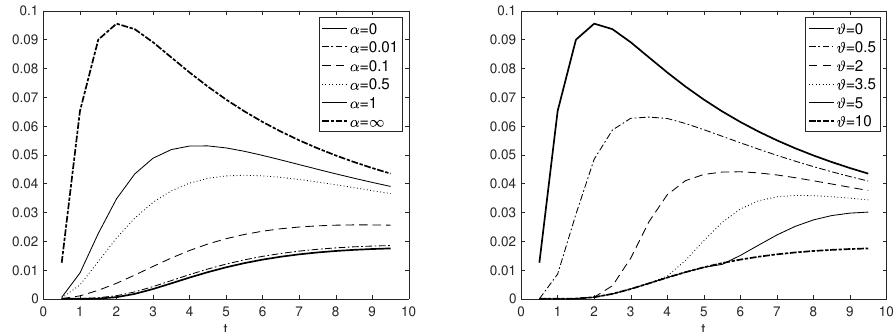
Figure 4. Graphs of implied hazard rate functions for the hazard rate model ( left ) and occupation time model ( right ). The underlying firm’s value is GBM with F 0 = 100, L 0 = 50, A 0 = 20, r f = 5%, σ = 30%, γ = 5%, and N = 30. For the right graph, we used 16 terms in the Gaver–Stehfest